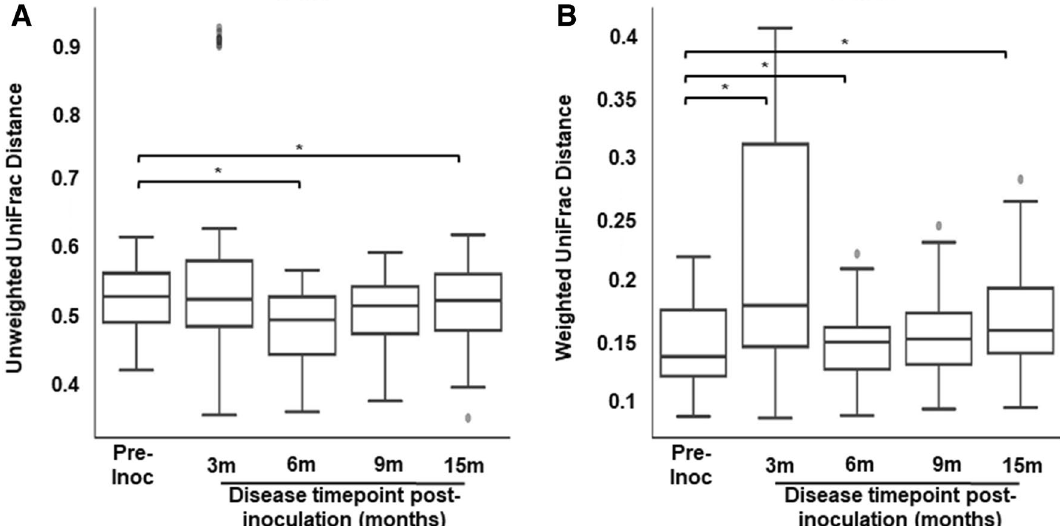
Figure 3. β diversity in gastrointestinal tract (GI) from pre- and post-inoculation of endometriosis using the ANOSIM algorithm. ( A ) Unweighted Unifrac, ( B ) Weighted Unifrac. The horizontal lines inside the boxes indicate the median, whereas the lower lines and upper lines of the boxes indicate the 25th and the 75th percentiles, respectively. The dots outside the boxes indicate the outliers. *Indicates significance between groups, p- value < 0.05. (Pre-inoc and 3 m post-inoc: unweighted p = 0.38, weighted p = 0.021; pre-inoc and 6 m post-inoc: unweighted p = 0.04, weighted p = 0.029; pre-inoc and 9 m post-inoc: unweighted p = 0.11, weighted p = 0.38; pre-inoc and 15 m post-inoc: unweighted p = 0.043, weighted p =